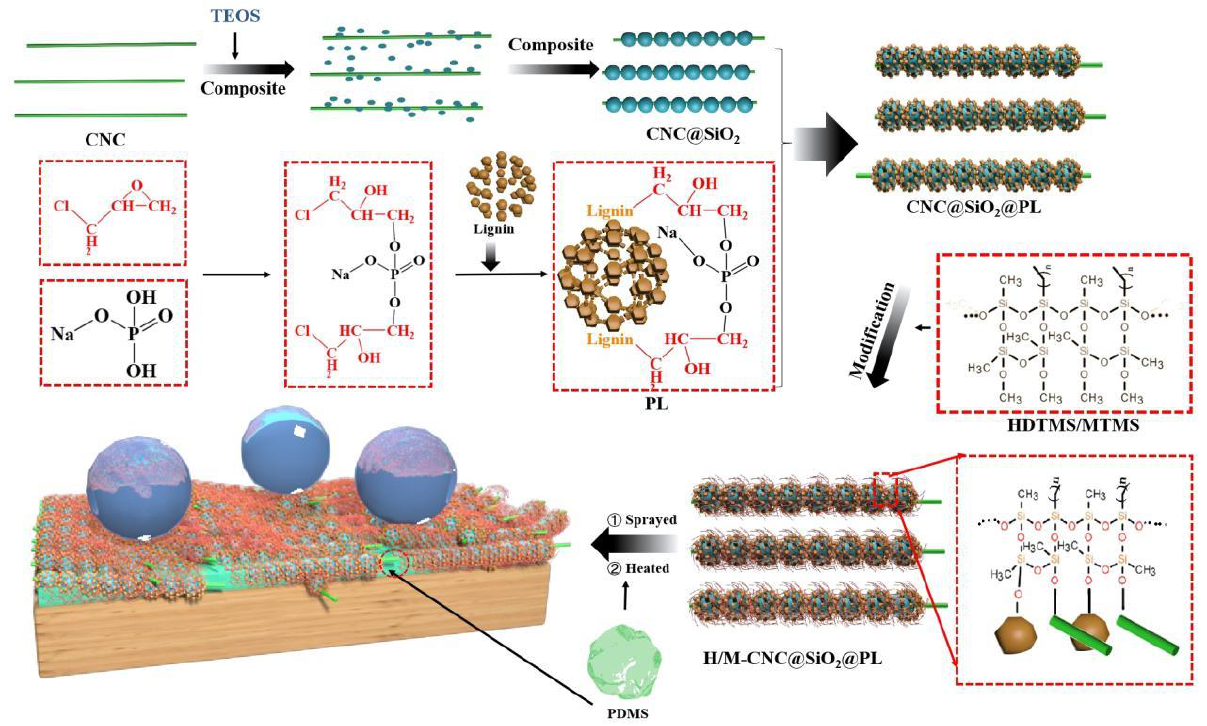
Figure 1. Preparation process demonstration and forming mechanism of CNC@SiO 2 @PL-based superhydrophobic wood, and possible chemical reactions during preparation.